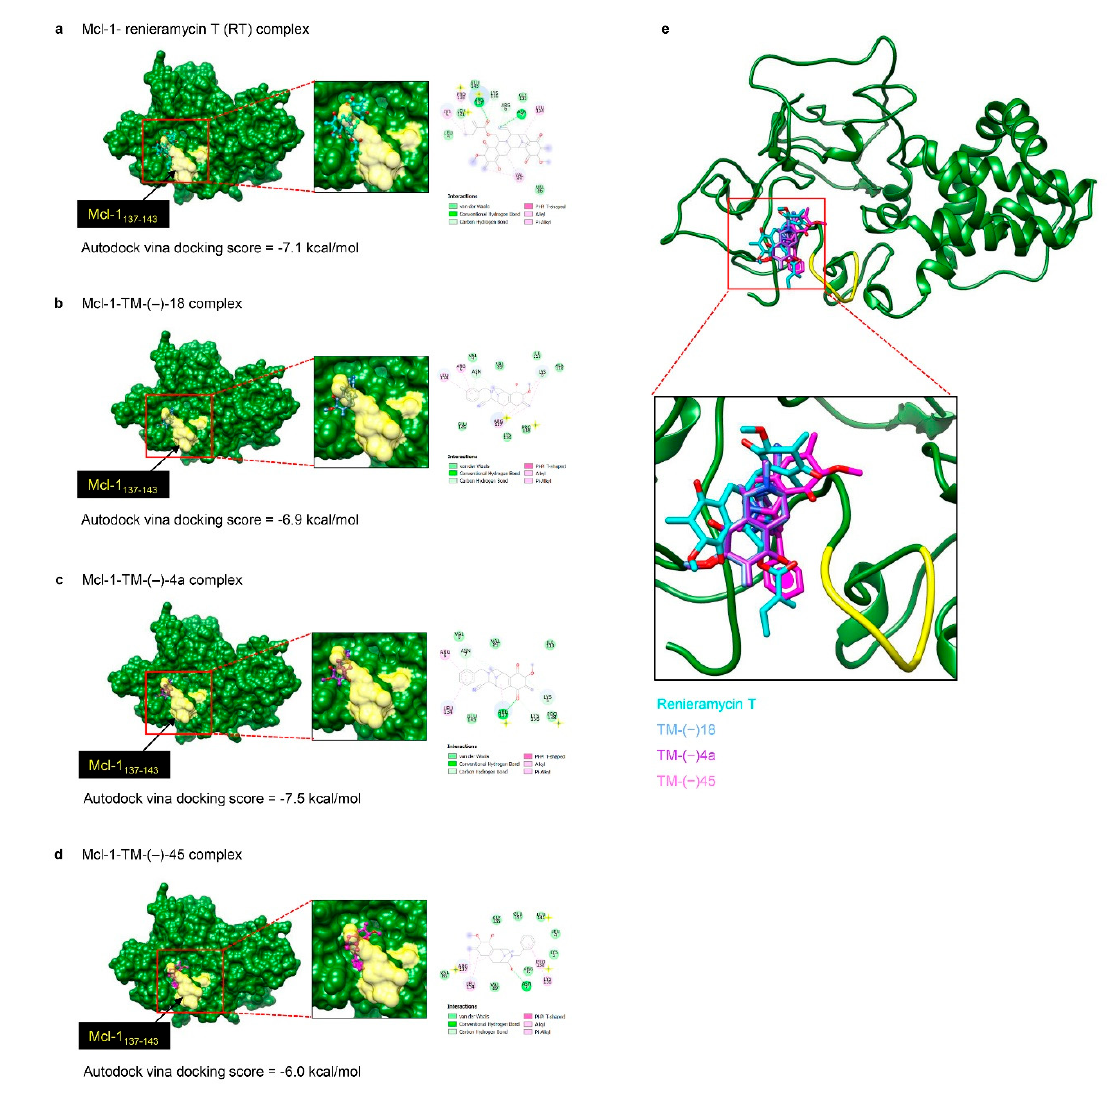
Figure 6. Binding mode and docking energy of: ( a ) renieramycin T, ( b ) TM-( − )-18, ( c ) TM-( − )-4a, and ( d ) TM-( − )-45 bound to the binding site of Mcl-1 (residues 137–143) taken from the AutoDock Vina molecular docking study. ( e ) Superimposition structure of each compound at the binding site of Mcl- 1.